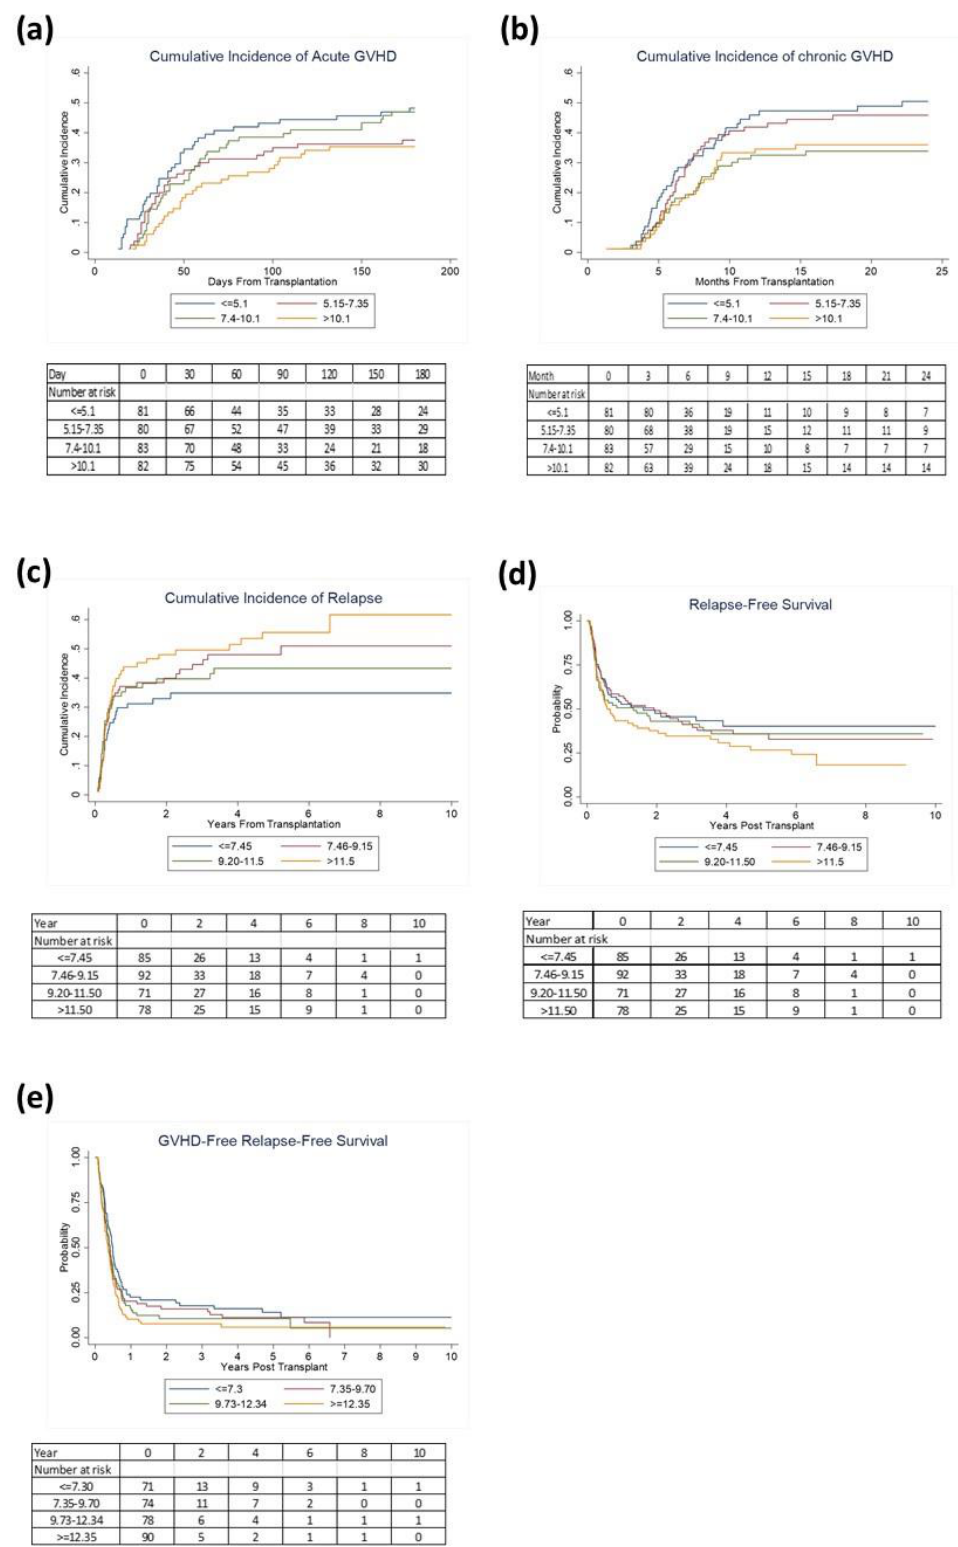
Figure 3. Association of TAC levels with the cumulative incidence of ( a ) grade II-IV aGVHD, ( b ) cGVHD, ( c )relapse, and probability of ( d ) relapse free survival, ( e ) GVHD free relapse free survival in AML/MDS